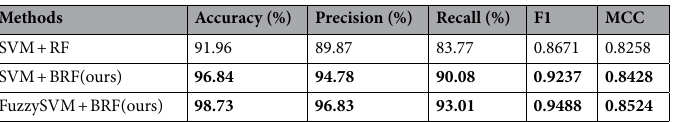
Table 5. Average results of fivefold CV for ensemble methods. Significant values are in bold.